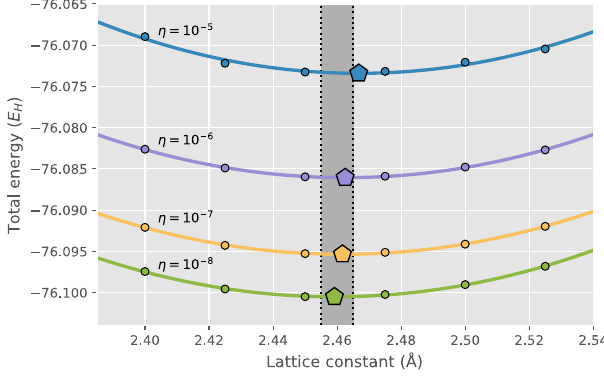
FIG. 11. Total energies of embedded CCSD of 10 × 10 gra- phene for different bath thresholds η . The gray stripe indicates the experimental range for the equilibrium lattice constant.